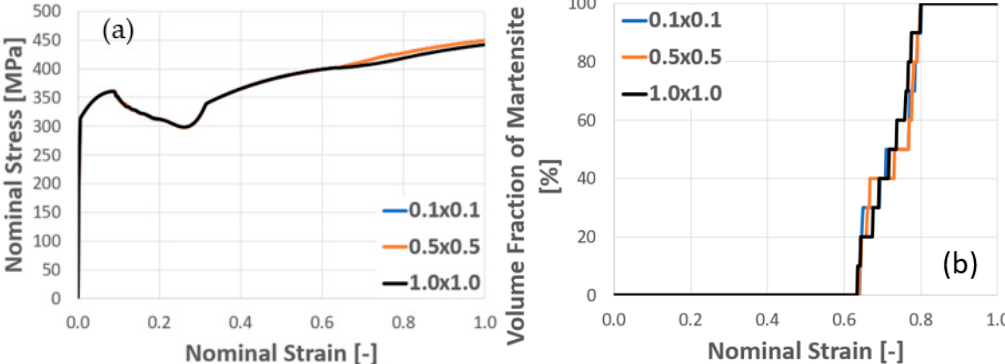
Figure 18. The dependence of the cell size ( a ) nominal stress versus nominal strain and ( b ) the volume fraction of martensite versus nominal strain.